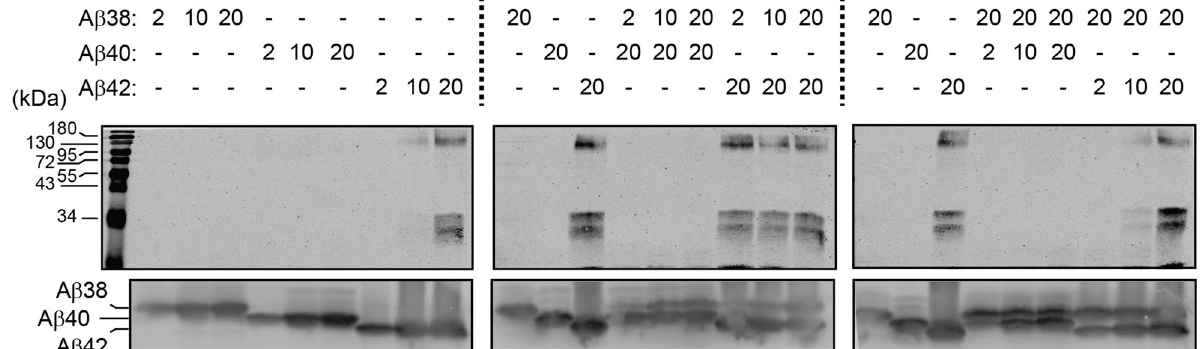
Figure 2. Aβ(1–38) interferes with Aβ(1–42) high molecular weight complexes on SDS-PAGE. Different concentrations (in µM) of Aβ(1–38), Aβ(1–40), or Aβ(1–42), either alone or as a mixture were incubated for 24 h and then resolved by gel electrophoresis. A protein ladder is shown in the first lane. Aβ high molecular weight complexes were visualized by standard 15% SDS-PAGE ( top panels ), while the different starting amounts of Aβ peptides themselves were visualized using an 8 M UREA / 12% SDS-PAGE system ( bottom blot ). Note that on urea gels, Aβ peptides migrate according to their hydrophobicity and, hence, Aβ(1–38) migrates slower (higher) than Aβ(1–40) or